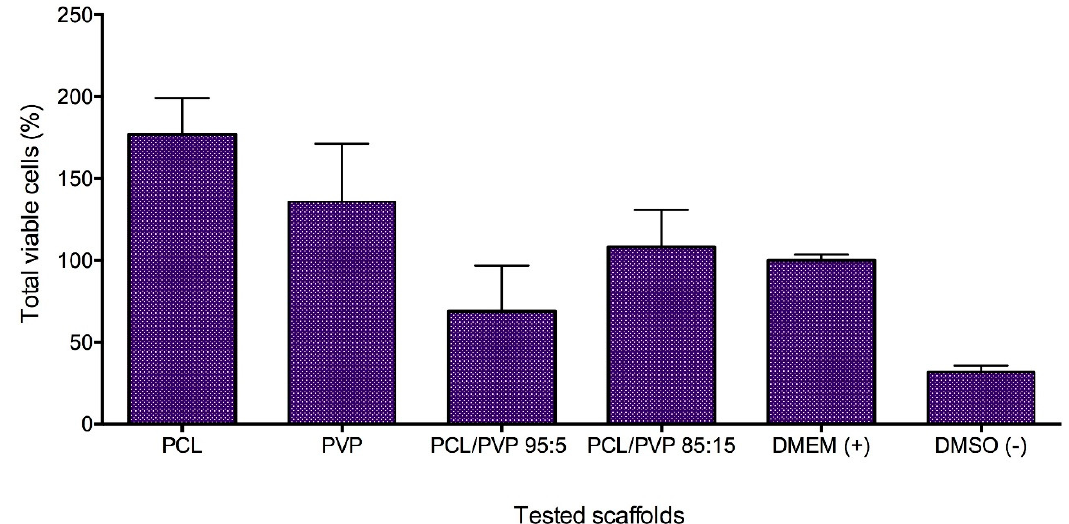
Figure 4. HFF-1 cell viability of electrospun fibers and controls (DMEM as the positive control and DMSO as the negative control).